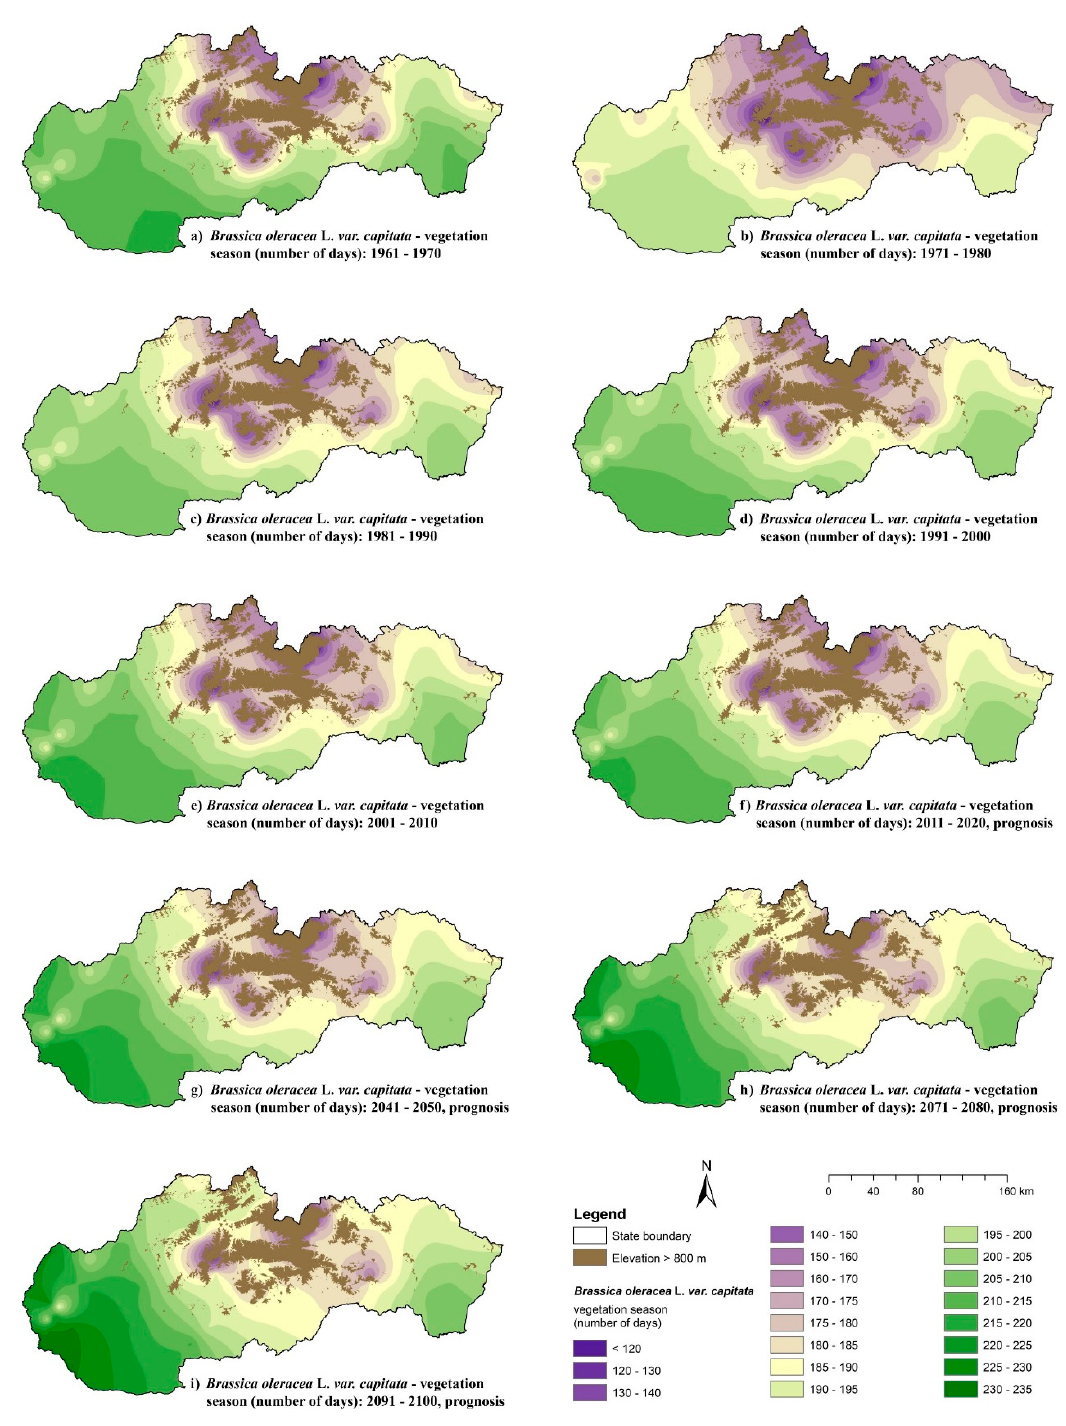
Figure 3. Vegetation period of Brassica oleracea L. var. capitata in the decades from 1961–2100: ( a ) 1961–1970, ( b ) 1971–1980, ( c ) 1981–1990, ( d ) 1991–2000, ( e ) 2001–2010, ( f ) 2011–2020, ( g ) 2041–2050, ( h ) 2071–2080, ( i ) 2091–2100.